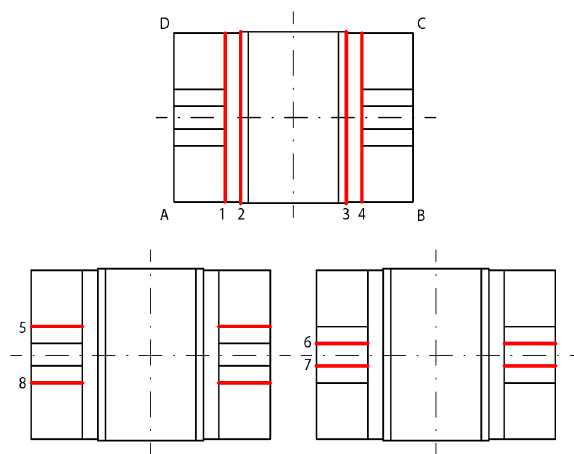
Figure 9 . Position of section planes (Processing: F. Natta).